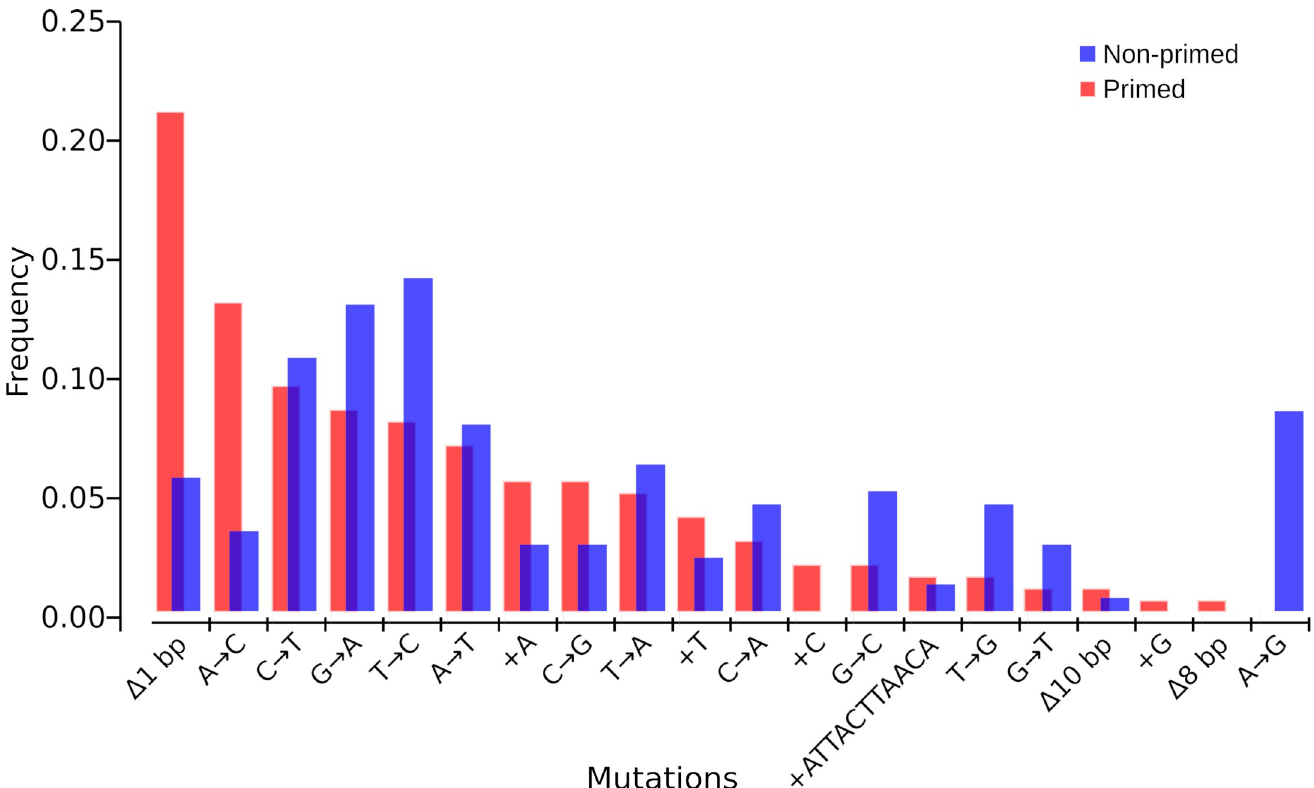
Fig 11. Frequencies of different types of mutations among evolved populations of both primed and non-primed conditions. Mutational spectra. The number of mutations (nucleotide substitutions and indels) is plotted against respective nucleotide positions within the gene fragment. In this analysis, the mutations were taken by type regardless of the targets by generating two frequency datasets to compare frequency by type of mutation of evolved populations under priming and non- priming regimes. The mutational spectra are significantly different between the two conditions according to the spectrum analysis software iMARS [46].